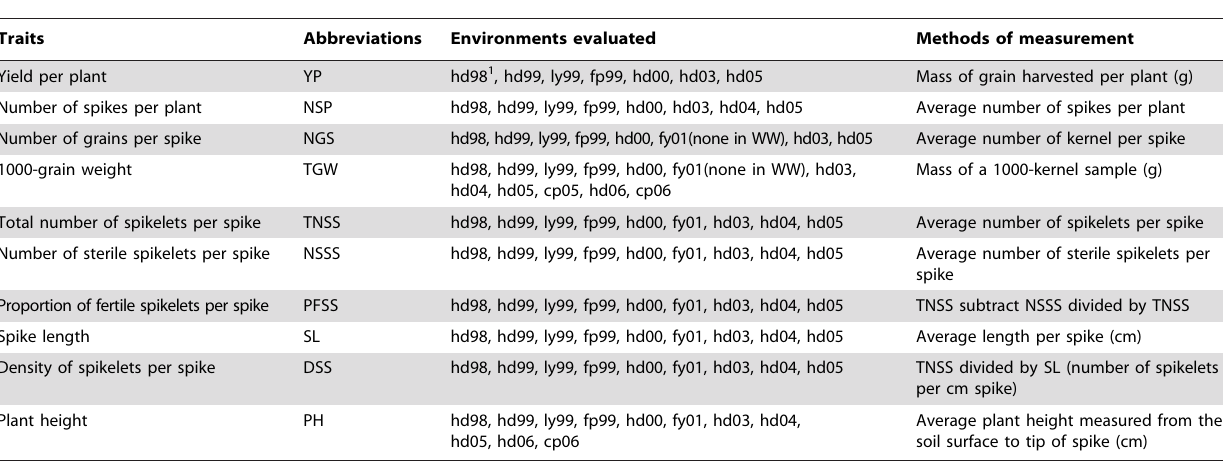
Table 12. Yield-associated traits with their environments evaluated in wheat DH